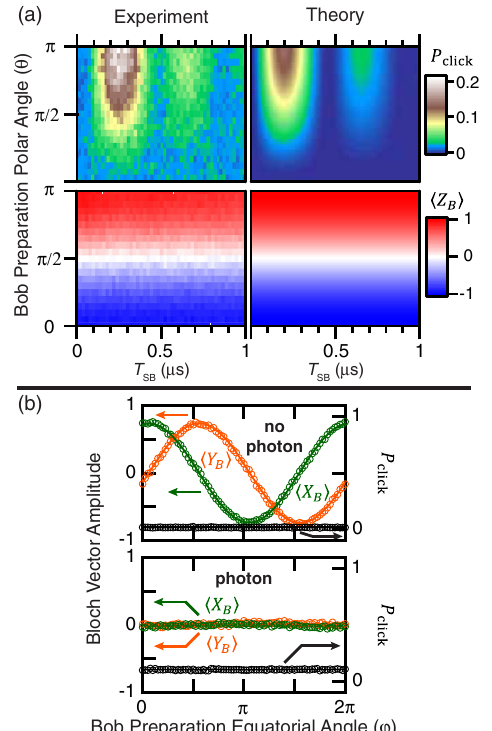
FIG. 8. Signatures of qubit-photon entanglement: data vs theory. These data are similar to those of Fig. 2, but they address the Bob module of the experiment and its equivalence to the Alice module. (a) Color plots of the probability P (top left) of the click detector qubit ending in j e i and the Bob qubit polarization h Z B i (bottom left) as a function of the sideband pulse length T when SB Bob was prepared in cos ð θ = 2 Þj g i þ sin ð θ = 2 Þj e i . A theoretical simulation, plotted on the right, shows good agreement. (b) De- tector click probability P and Bob equatorial Bloch vector click components, h X and h Y , as a function of ϕ when Bob was ffiffiffi A i A i p 2 prepared in ð 1 = Þðj g i þ e i ϕ j e iÞ and the CNOT-like operation was either performed (bottom) or not (top). Open circles are experimental data, and lines are